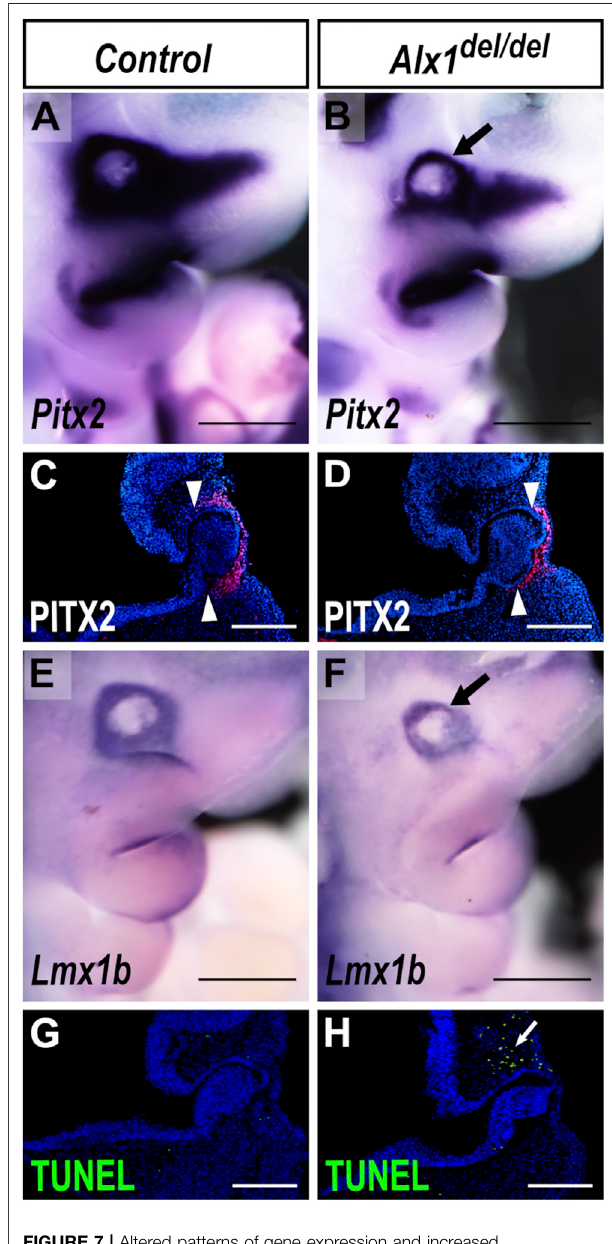
FIGURE 7 | Altered patterns of gene expression and increased apoptosis of the periocular mesenchyme in Alx1 del/del embryos. (A, B) Lateral views of whole mount embryo heads showing Pitx2 mRNA expression (blue/ purple color) in control (A) and Alx1 del/del (B) embryos at E10.5. Arrow in (B) points to the reduction in the domain of Pitx2 expression in the periocular region in Alx1 del/del embryos. (C, D) Representative frontal sections of E10.5 embryo heads showing immuno fl uorescent staining of PITX2 protein (red) in the periocular mesenchyme in wildtype (C) and Alx1 del/del (D) embryos. White arrowheads in (C, D) point to the restricted domain of PITX2 expression in control and Alx1 del/del embryos, respectively. (E, F) Lateral views of whole mountembryoheadsshowing Lmx1b expression(blue/purplecolor)incontrol (E) and Alx1 del/del (F) embryos at E10.5. Arrow in (F) points to the reduction in the domain of Lmx1b expression in the Alx1 del/del embryo. (G, H) Representative frontal sections of E10.5 embryo heads showing TUNEL staining (green) in the periocular mesenchyme in wildtype (G) and Alx1 del/del ( Continued )